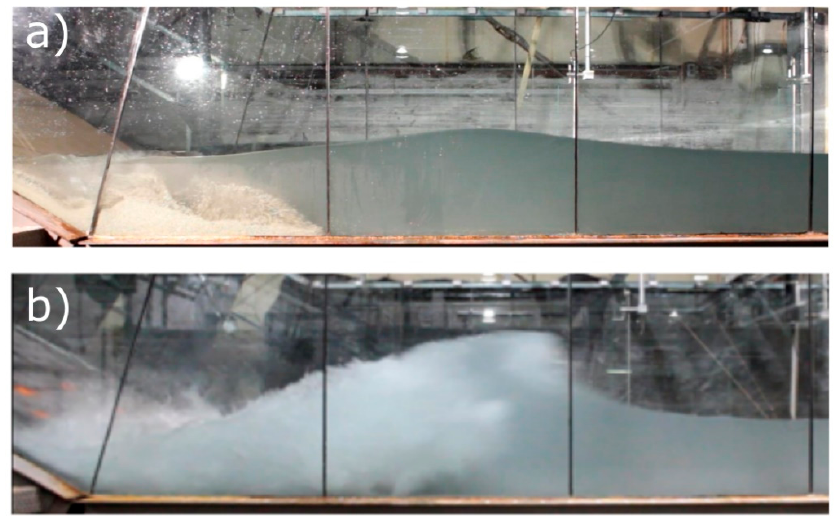
Figure 2. Images of the waves generated by landslides with di ff erent mobility: ( a ) low mobility; ( b ) high mobility.